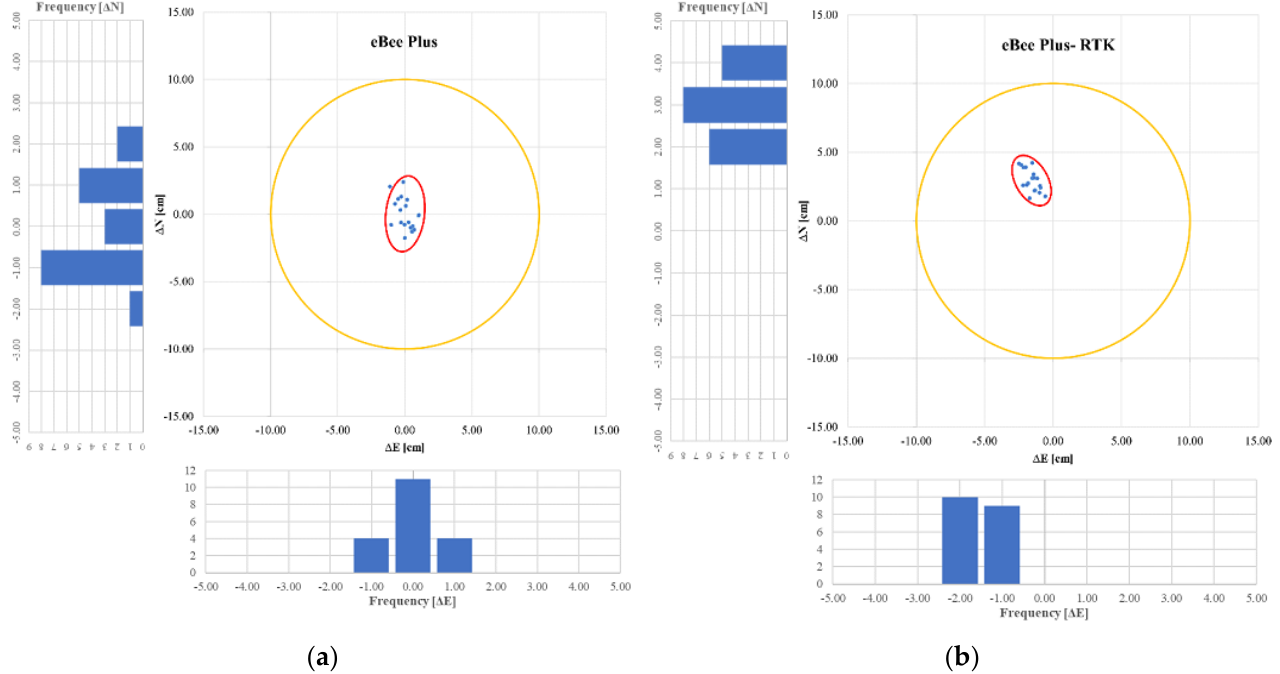
Figure 9. Confidence ellipse — eBee with GCPs at 60 m ( a ); Confidence ellipse — eBee without GCPs (RTK) at 60 m ( b ).